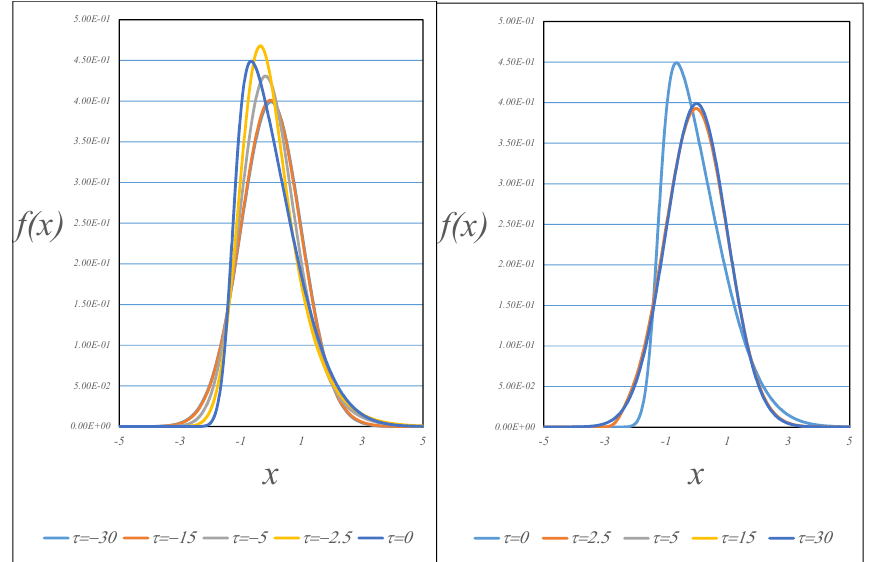
Figure 4. Standardized Extended Skew-Normal Density